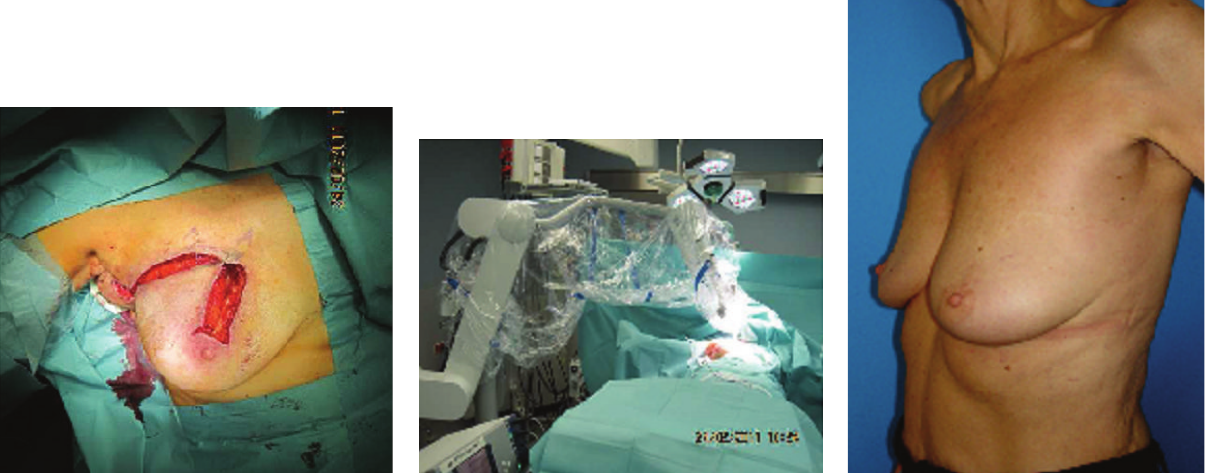
reduction mammoplasty ( 𝑛 = 11 ). Seroma formation 4 weeks after oncoplastic surgery and IORT boost was only observed in 2%. The esthetic outcomes were excellent in more than 90% in patients’